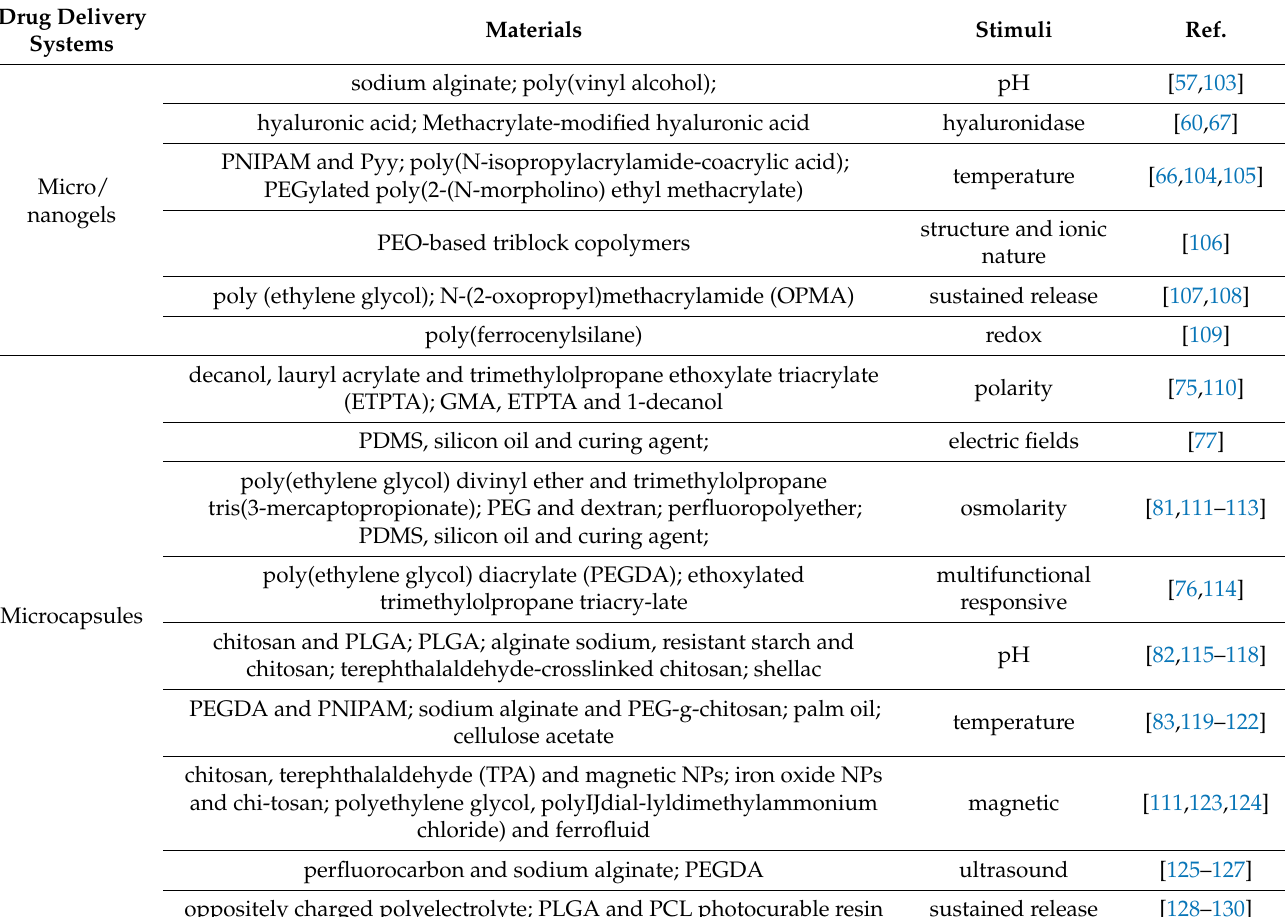
Table 1. Stimuli-responsive strategies for micro/nanoparticles drug delivery systems. Drug Delivery